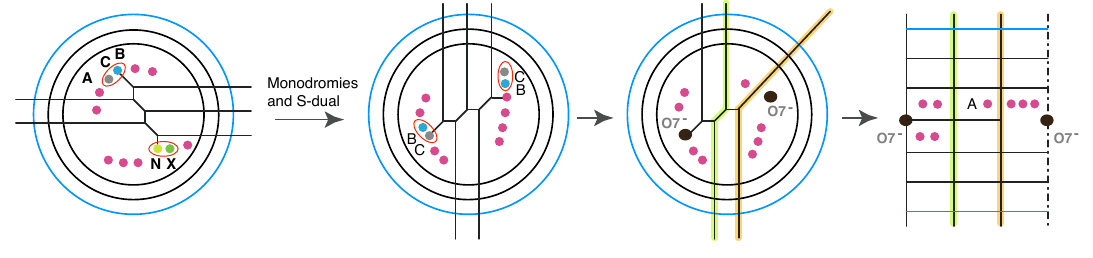
Figure 47 . A T-dual version of 6d [1 A ; 8] (cid:0) SU(5) (cid:0) SU(5) (cid:0) SU(5) (cid:0) [5] yielding 5d [1 A ; 4] (cid:0) SU(7) (SU(7) [1]) Sp(3) [3] implementing S-dual invariant 7-brane (cid:0) (cid:0) (cid:0) (cid:0)